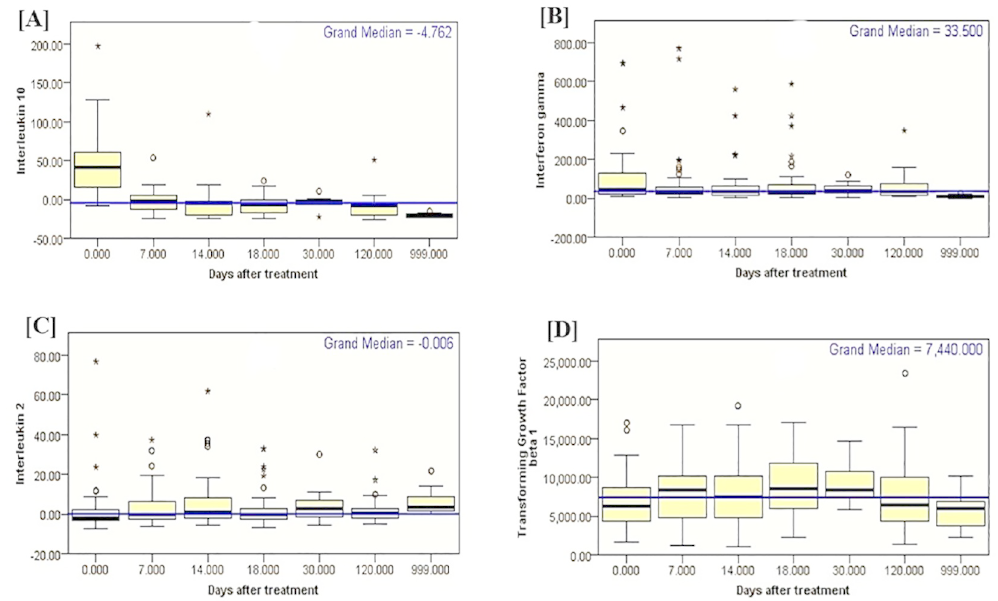
Fig 3. Box plots showing serum cytokine concentrations of IFN- γ , IL-10, TGF- β 1, and IL-2 in pg/ml (Independent sample median tests). days, the IL-10 concentration was 60.70 pg/ml before treatment at day 0. The patient had to be re-treated with SSG (30 days, at a dose of 20 mg/kg) as ToC on day 18 revealed a parasite grade of 2+. After 30 days of treatment, the splenic aspirate revealed a sustained parasite grade of 2+, at which point the IL-10 concentration was 98.3 pg/ml. Finally, the patient was treated with amphotericin B (AmBisome) and discharged with microscopy negative results, and that stage IL-10 concentration was 10.48 pg/ml. INF- γ . Serum concentrations of IFN- γ at day 0 (median 47.4 pg/ml; IQ range 21.9 − 134.6 pg/ml) was measured in sera of 48 VL patients and in the consecutive post-treatment day 7 (median 33.3 pg/ml; IQ range 19.7 − 68.5 pg/ml); day 14 (median 35.2 pg/ml; IQ range 16.0 − 65.9 pg/ml); day 18 (median 33.4 pg/ml; IQ range 26.2 − 56.5 pg/ml); day 18 EOT (median 43.0 pg/ml; IQ range 19.3 − 80.3 pg/ml); day 30 EOT (39.5 pg/ml; IQ range 28.8 − 78.3 pg/ml); and, day 120 (median 33.5 pg/ml; IQ range 13.3 − 74.1 pg/ml). IFN- γ serum concentration of healthy controls (n = 20) had median and IQ ranges of 8.0 pg/ml; (2.6 − 10.7 pg/ml) (Figs 2–4 and S6 Table). Concentrations of IFN- γ before treatment and in consecutive post-treatment serum samples of VL patients were significantly ( p < 0.001) higher than plasma samples of healthy controls at 0.05 (Kruskal-Wallis 1-way ANOVA for k samples). TGF- β 1. Median concentrations of TGF- β 1 in sera of VL patients were 6215.0 pg/ml (IQ range 4090.0 − 8690.0 pg/ml) at day 0; 8390.0 pg/ml (IQ range 4815.0 − 10315.0 pg/ml) at day 7; 7540.0 pg/ml (IQ range 4740.0 − 10465.0 pg/ml) at day 14; 8515.0 pg/ml (IQ range 7165.0 − 10365.0 pg/ml) at day 18; 8340.0 pg/ml (IQ range 5927.5 − 13040.0 pg/ml) at day 18 EOT; 8365.0 pg/ml (IQ range 7265.0 − 11665.0 pg/ml) at day 30 EOT; and 6365.0 pg/ml (IQ range 4290.0 − 10540.0 pg/ml) at day 120. The corresponding median concentrations in serum of healthy controls were 5990.0 (IQ range 3752.5 − 6840.0 pg/ml) (Figs 2 and 3 and S6 Table). The pairwise comparison of TGF- β 1 serum concentrations using Kruskal-Wallis 1-way ANOVA didn’t indicate SSDs at ( p � 0.05) across the various post-treatment schedules in VL patients.